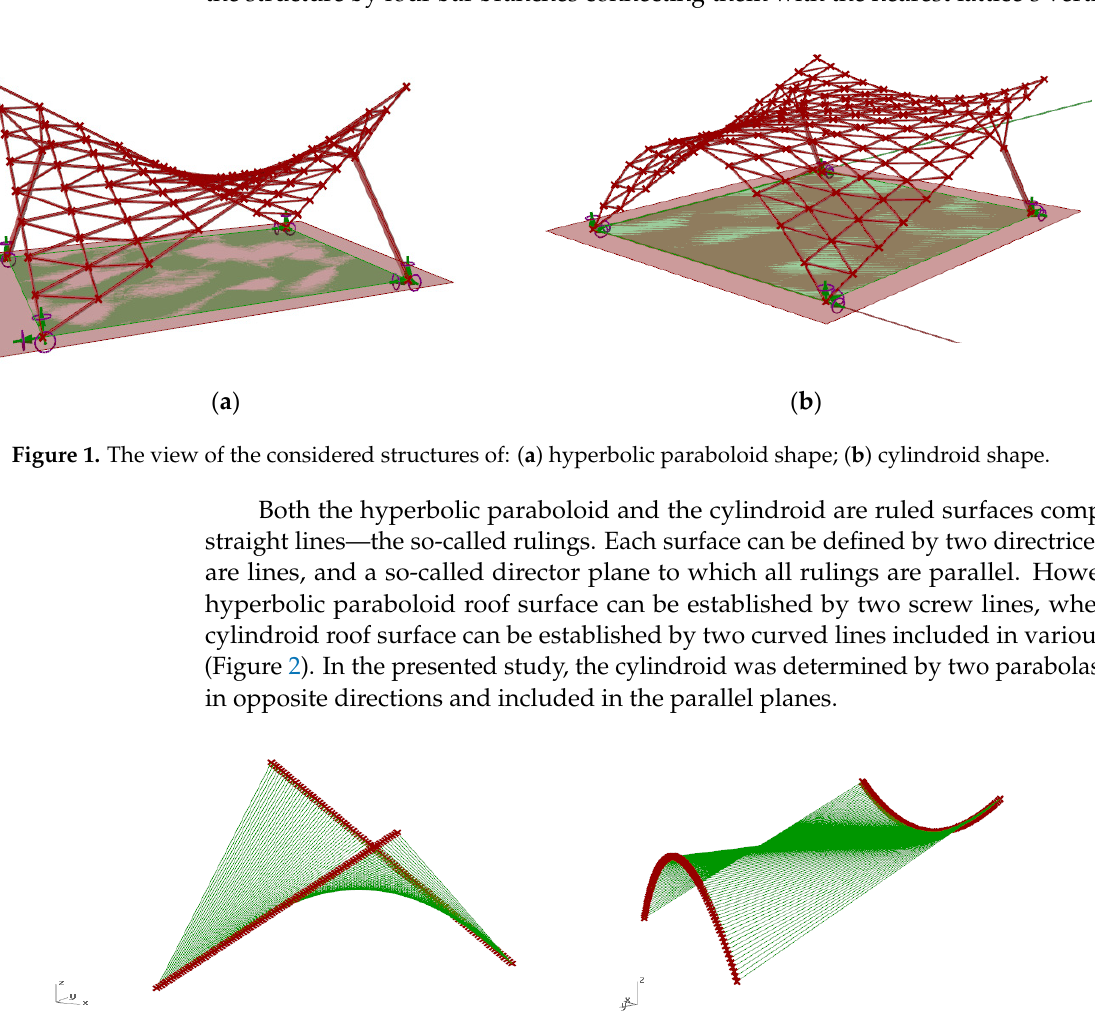
of surface discretization differ depending on the number of faces applied, their curvature and shape, as well as the number and complexity of the nodes. In the presented case studies, planar faces (panels) were applied, which are always preferred to curved panels due to the production cost. In order to achieve flat panels, each of the obtained spatial polygons was divided into two triangles. As a result of such discretization, two kinds of triangular bar grids with different patterns were obtained. This was due to the fact that every grid quadrangle